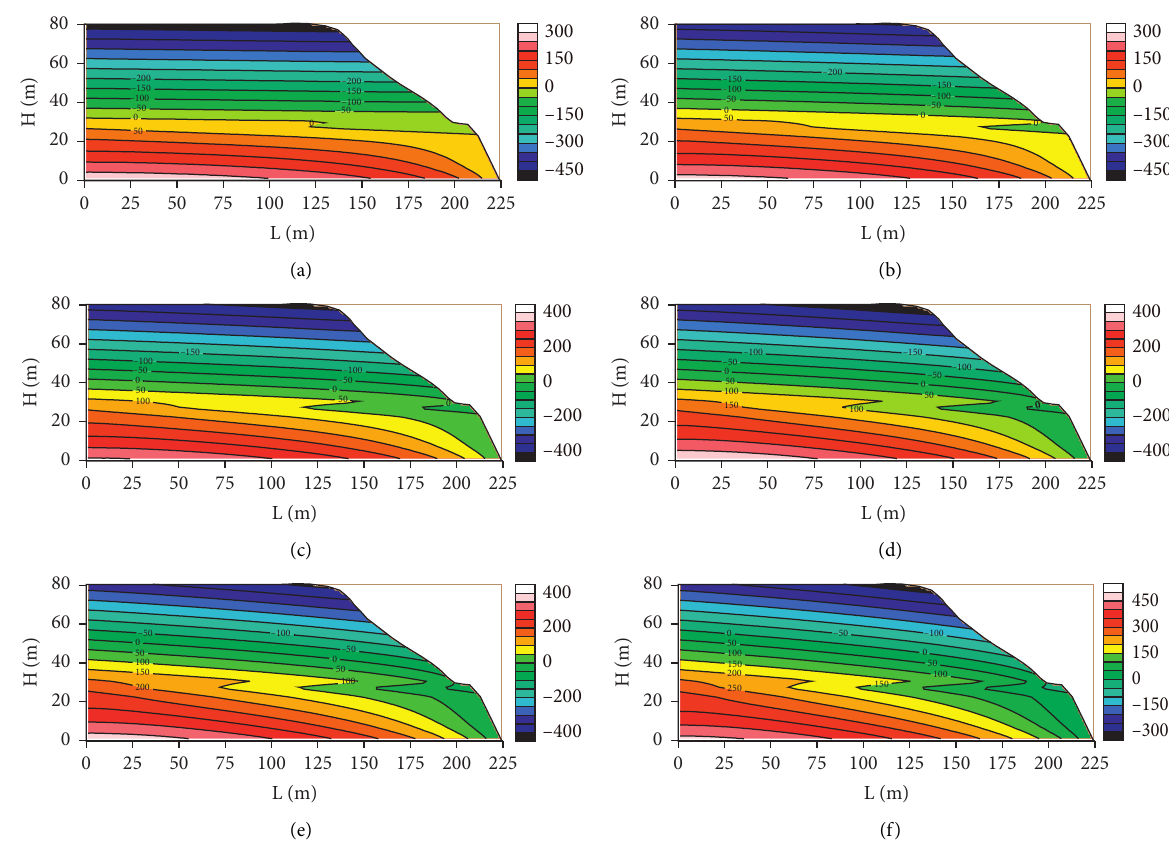
Figure 11: The distribution of pore pressure of different groundwater level. (a) 31 m. (b) 36 m. (c) 41 m. (d) 46 m. (e) 51 m. (f) 56